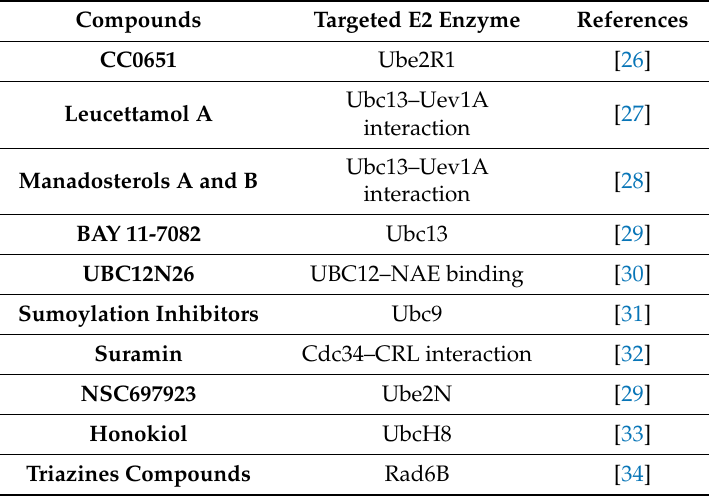
Table 1. Summary of compounds targeting E2